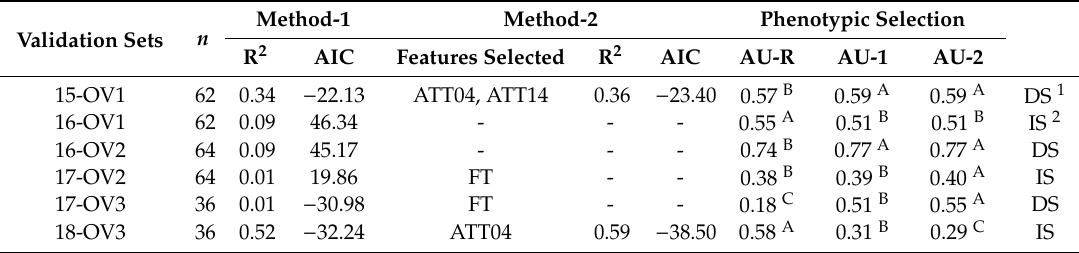
Table 3. Performance of models for FHB severity regarding the overlapping lines evaluated in consecutive